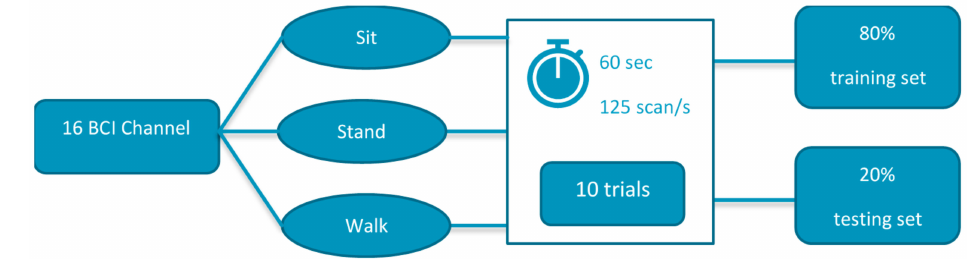
Figure 11. Schematic for part I of the experiment (BCI